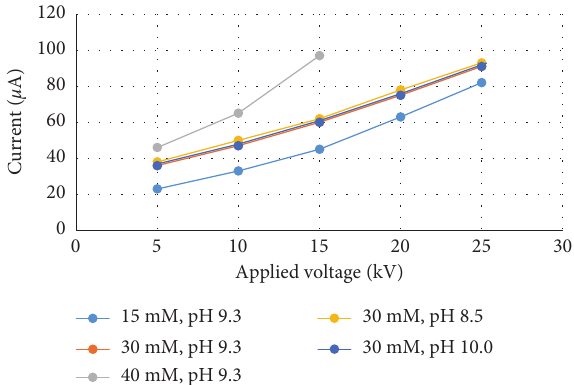
Figure 2: Relationship between the current and applied voltage at different concentrations and pH of sodium tetraborate